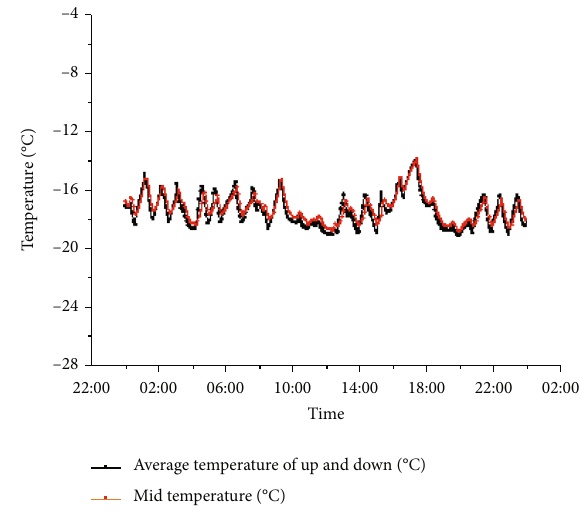
Figure 2: Average temperature and midtemperature of measuring points at vertical position